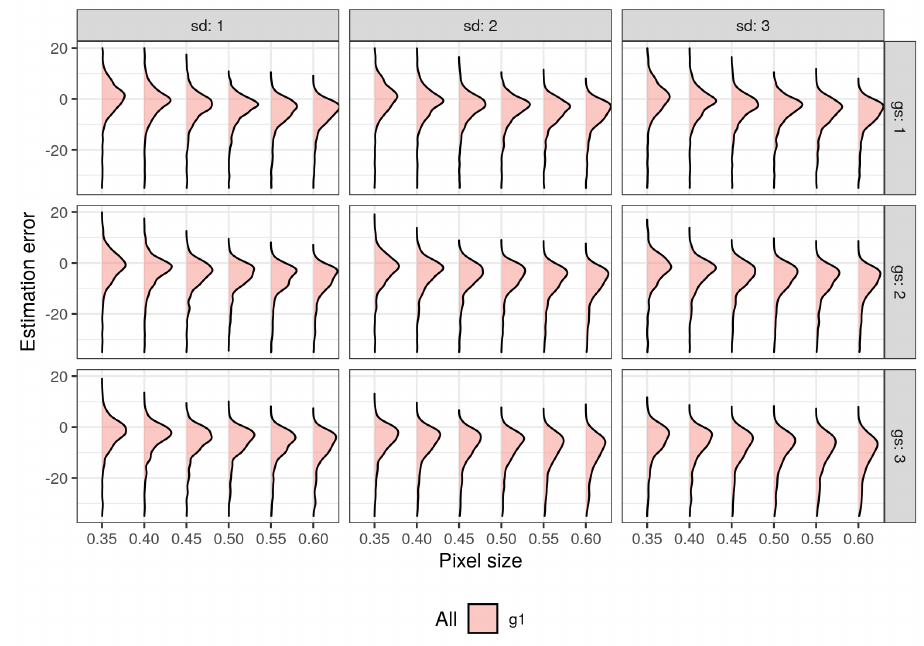
Figure 12. Distribution of estimation error of number of trees over all sample plots dependent on Watershed method parameterization—Canopy Height Model (CHM) spatial resolution (pixel size in meters), Gaussian smoothing strength (Gaussian filter window size (gs) and standard deviation (sd) in